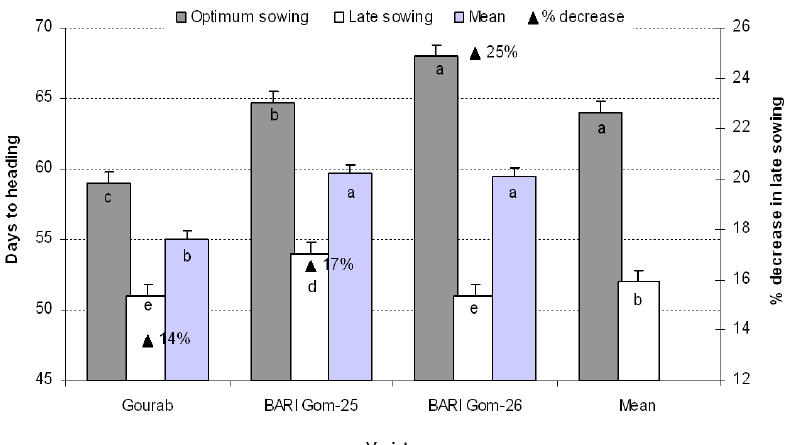
Fig. 5. Days passed to heading of 3 wheat varieties when sown under optimum and very late conditions. Mean (±SD) was calculated from three replicates for each treat- ment. Bars with different letters are significantly different at p ≤0.05 (LSD